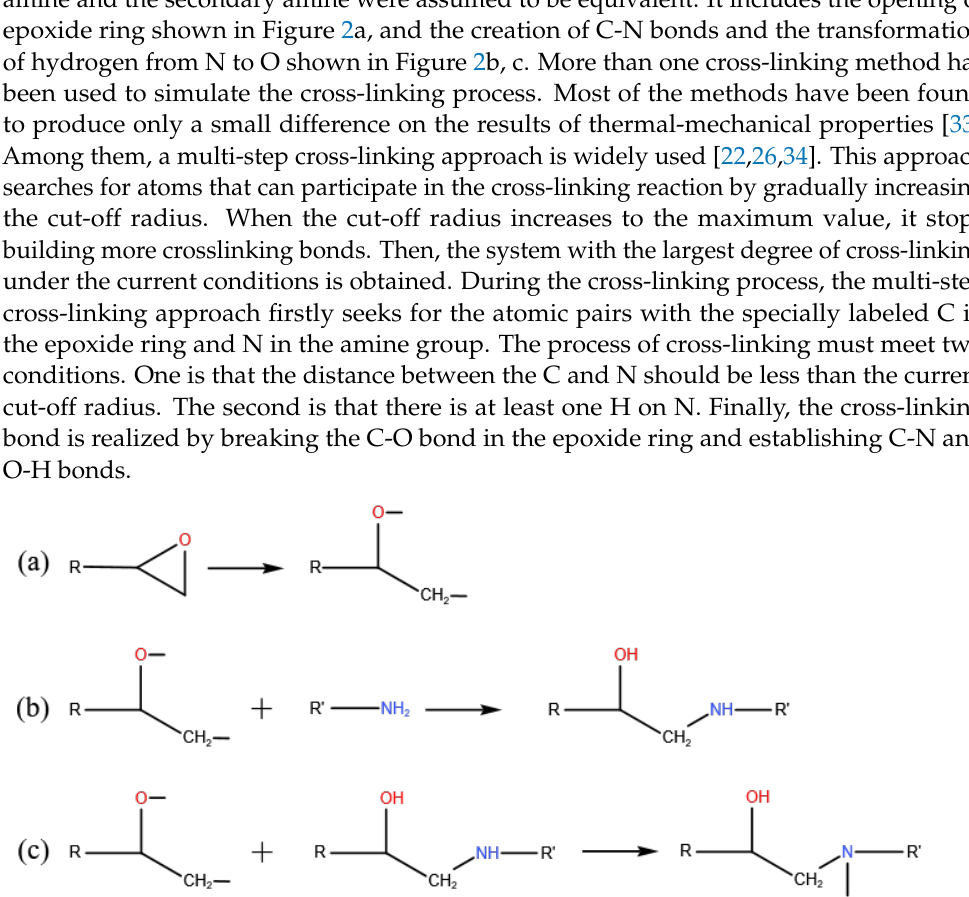
Figure 1. Molecular structure diagram of ( a ) DGEBA and ( b ) JEFFAMINE ® -D230 (x = 2.6) molecule.